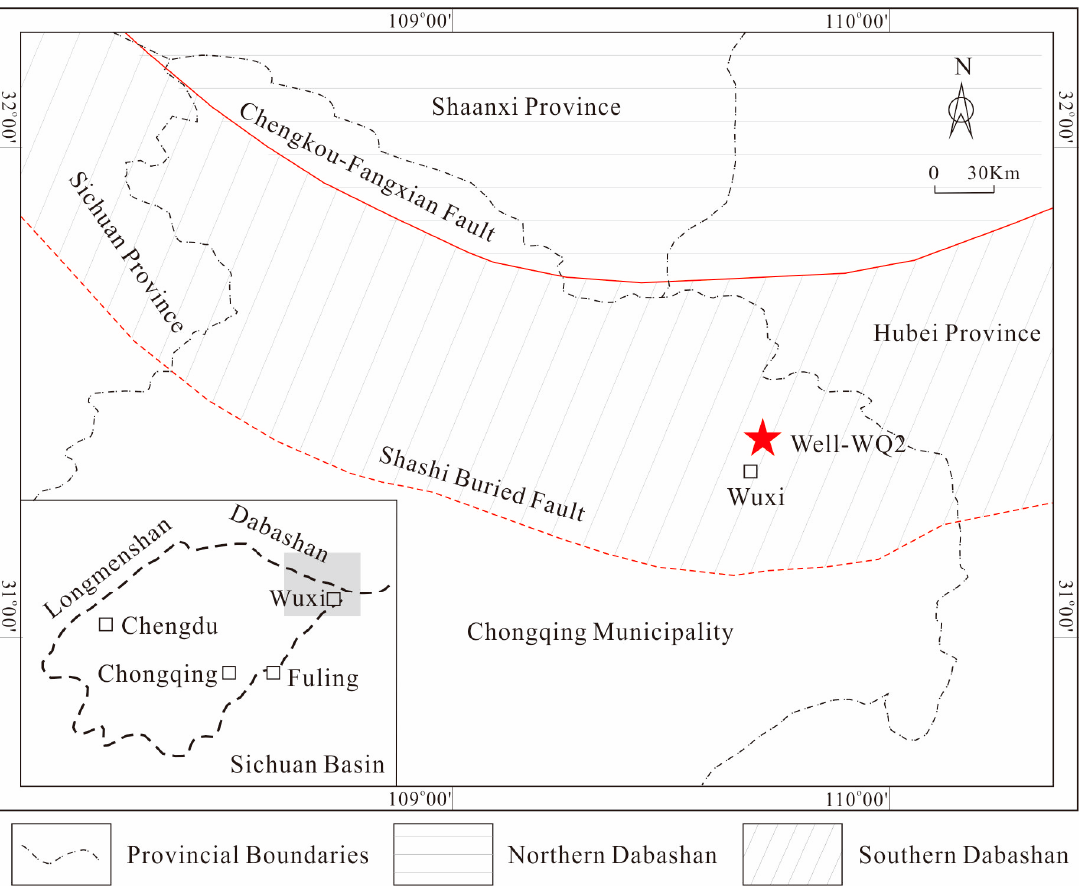
Figure 1. Locations of the northeastern Sichuan Basin, tectonic provinces, and sampled shale gas well.